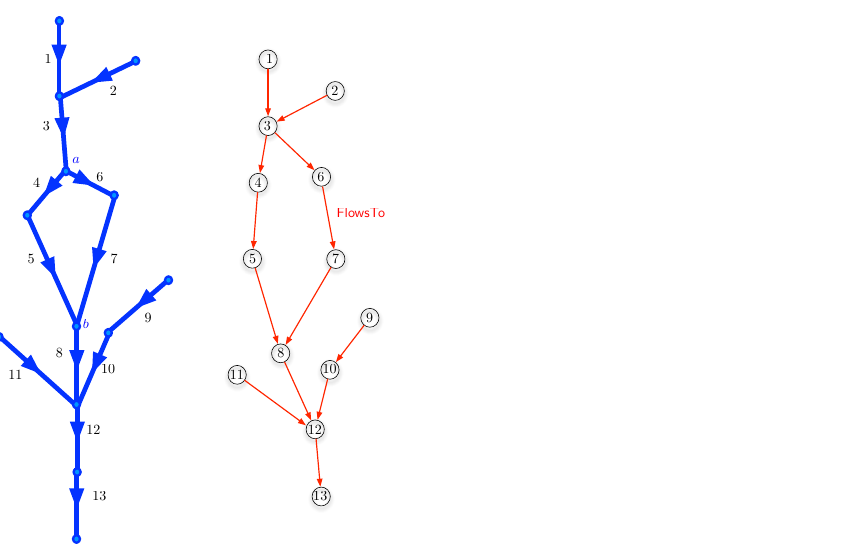
Figure 1. A fragment of a river system is shown on the left-hand side. The river is represented as a topology consisting of different segments. The numbered river segments carry arrows that indicate the flow of the water. On the right-hand side, the corresponding transportation network is shown. Here, the river segments are represented as nodes and the edges indicate the direction of the flow of the water. In other words, the arrows represent the FlowsTo